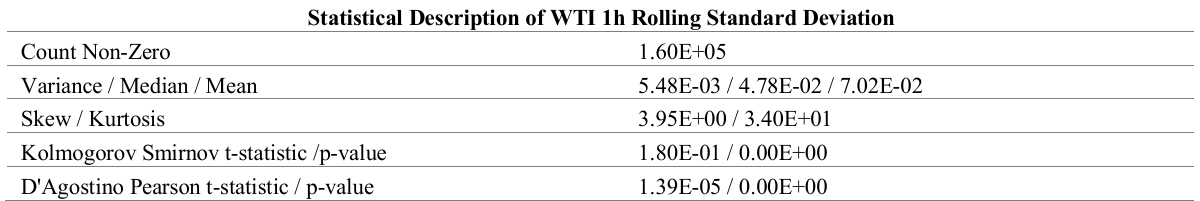
Table 2: Data statistics of a one hour window rolling standard